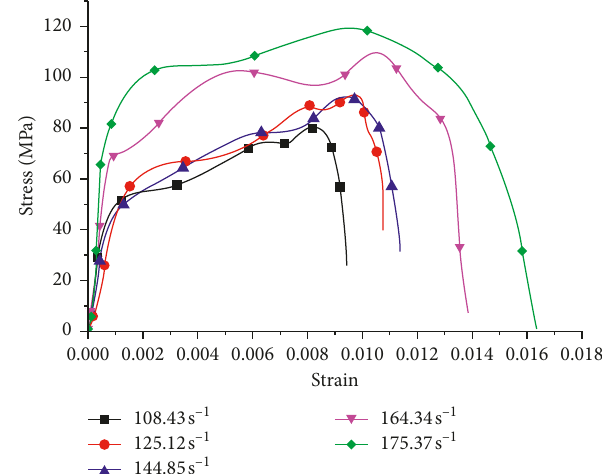
Figure 3: Typical stress-strain curves of vertical-bedding shale samples at different strain